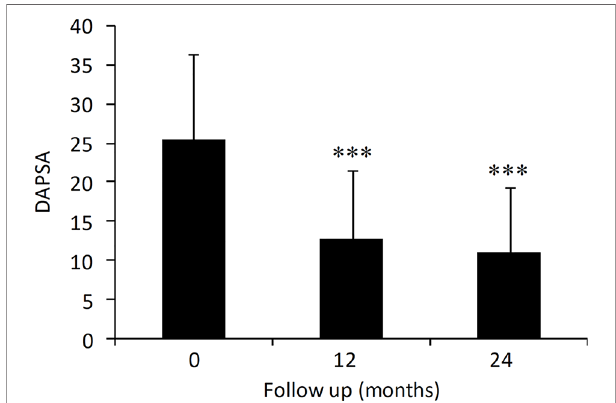
FIGURE 2 | Effect of adalimumab treatment in PsA patients on DAPSA (N = 209, 183, 189 at 0, 12 and 24 months). DAPSA, disease activity in psoriatic arthritis. Data are presented as mean ± SD. Asterisks denote statistically signi fi cant differences compared to baseline values after 1-way ANOVA followed by Bonferroni post-hoc